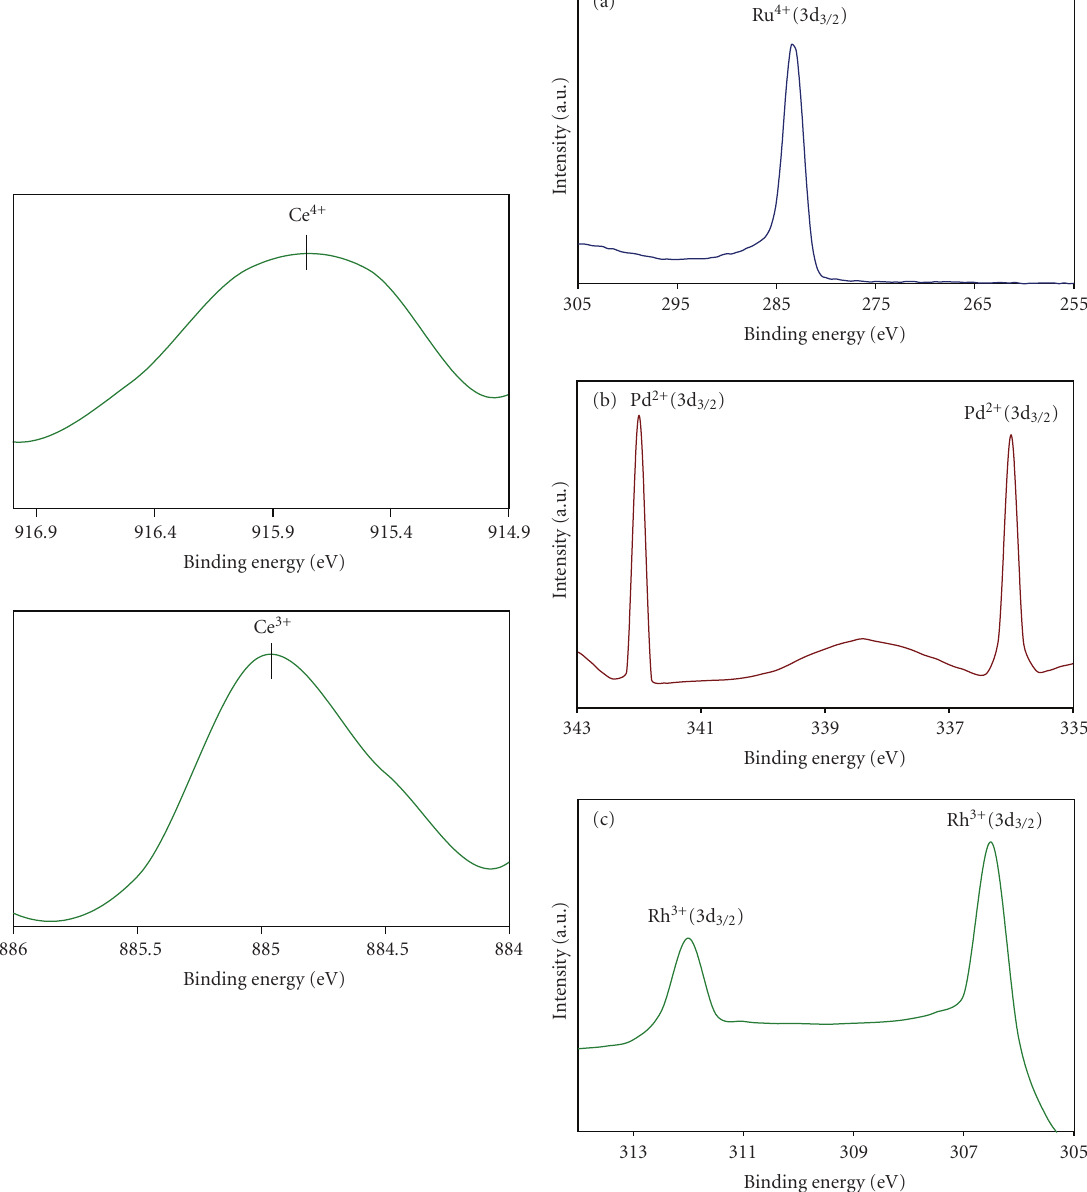
Figure 13: Characteristics XPS signatures of the precious metals in the postreformation catalysts; those for Ce(3d) seen in various oxidation states are also